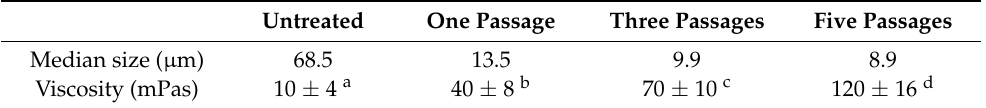
Table 1. Median sizes from particle size distributions and viscosities of wet-type grinder-treated okara (2 wt%) at a shear rate of 0.5 s − 1 after different passages (25 °C).